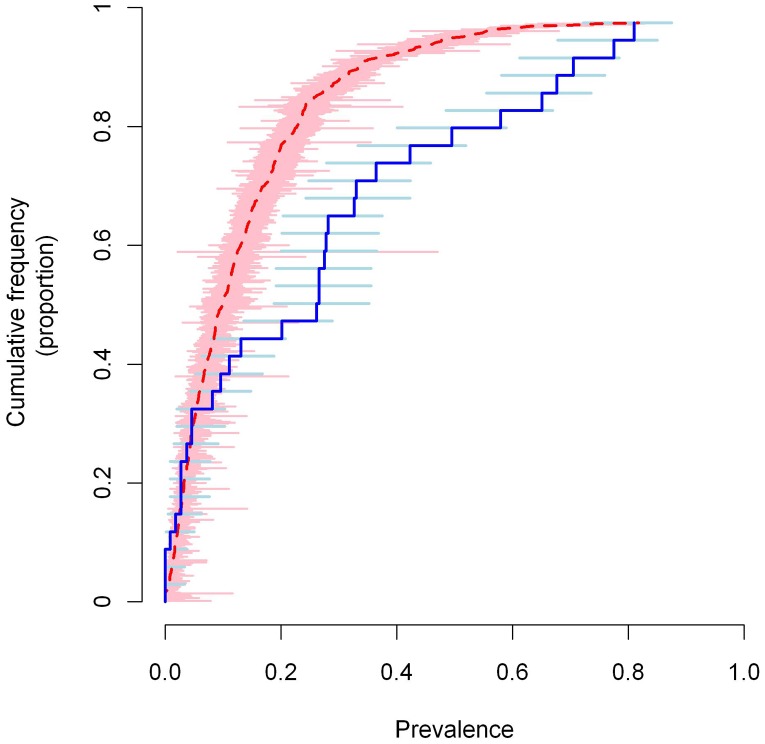
Cumulative frequency plots of the reported blood in urine and infection data.Estimates of the proportion of school children reporting blood in urine in 614 schools is shown in red and estimates of the prevalence of S. haematobium infection in 33 schools in blue. Horizontal bars indicate the 95% confidence intervals.